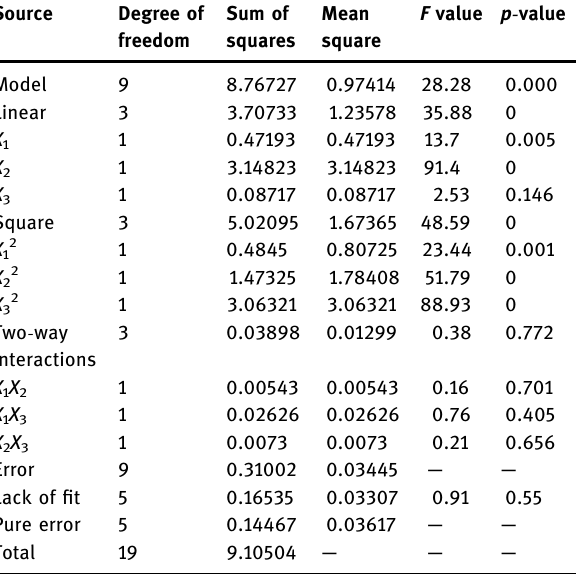
Table 3: Analysis of variance ( ANOVA ) of the fi tted quadratic polynomial model